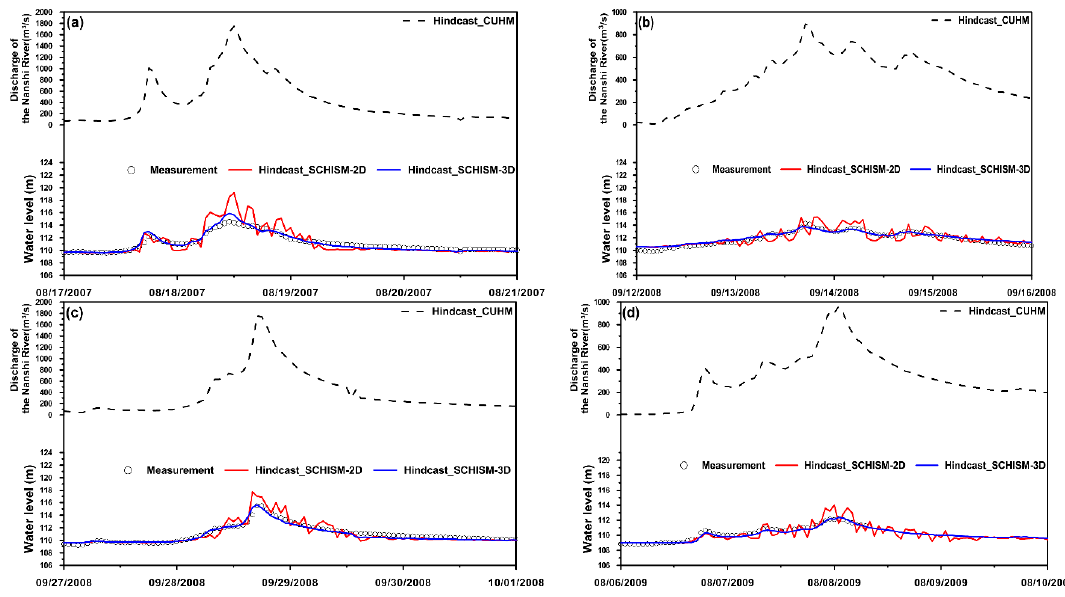
Figure 8. Comparison of the modeled and observed water levels at the Lansheng Bridge during the di ff erent high-flow events: ( a ) represents August 17–20, 2007; ( b ) represents September 12–15, 2008; ( c ) represents September 27–30, 2008; and ( d ) represents August 6–9, 2009. The upper panels in each figure are the inflow derived from the CUHM (Clark Unit Hydrograph